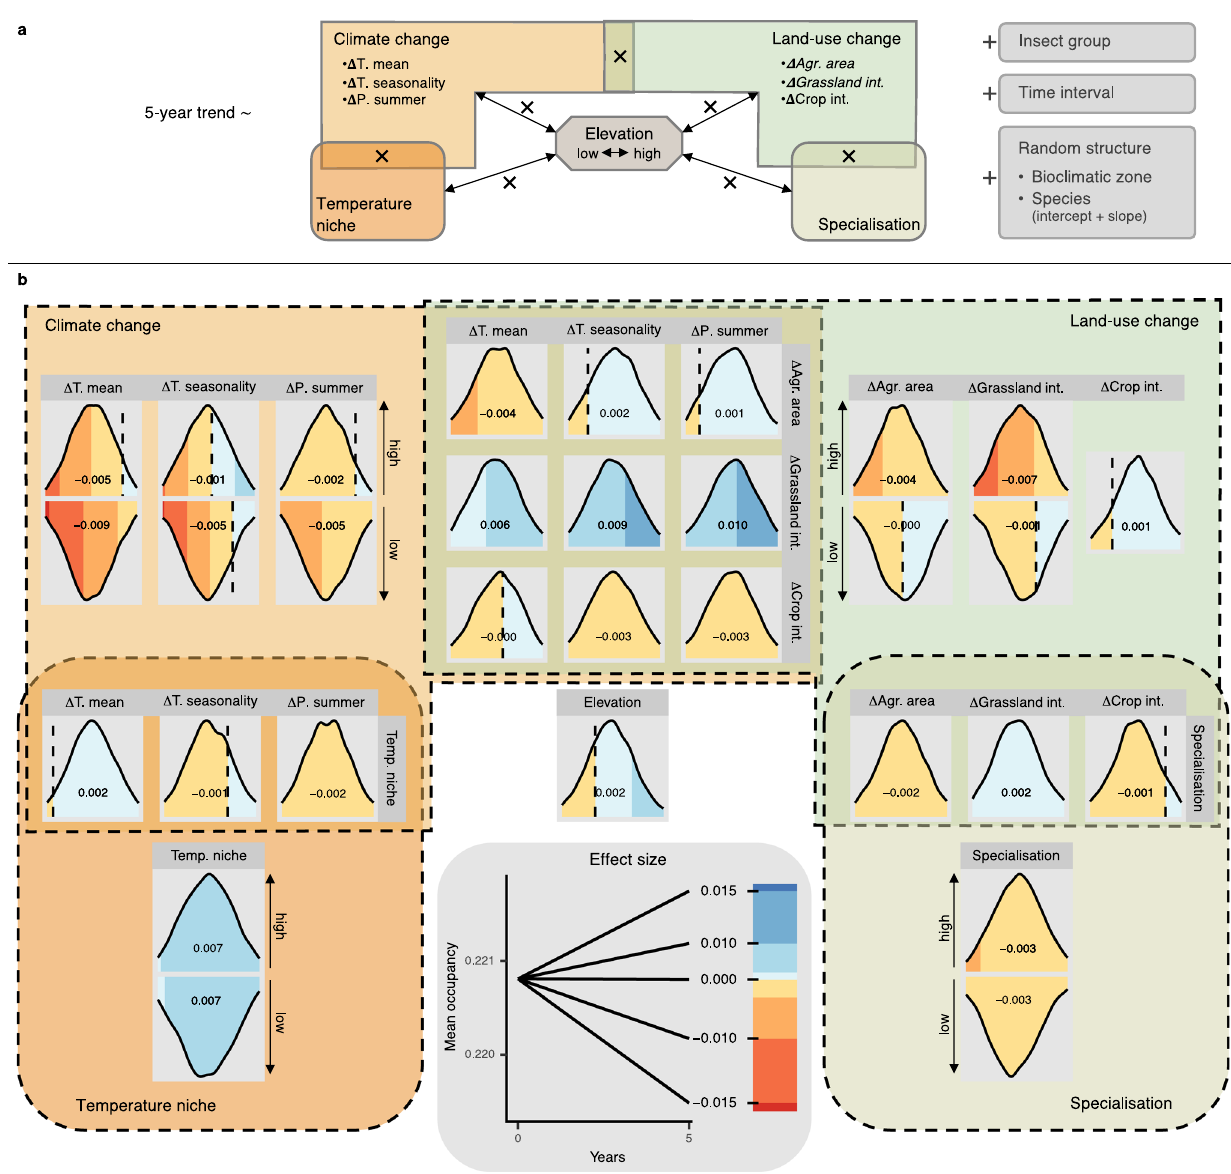
Fig. 3 | Regression model linking climate / land-use changes and species traits to short-term species trends. a Schematic model representation. The response variable was 5-year species trends of regional mean occupancy ( n tot = 20,048). Explanatory variables included changes in climate (annual mean temperature, temperature seasonality, summer precipitation) and land use (total agricultural area,grassland-useintensity,crop-useintensity),twotraitvariables,elevation(low or high) and interactions (indicated with ×) (cf. Fig. 1). In the restricted model version underlying the results presented in panel ( b ), parameter estimates for change in total agricultural area and grassland-use intensity (in italic) were only based on species of agriculturally in fl uenced habitats (183 butter fl y species, 93 grasshopper species; n =13,968). Non-independence within insect groups, time intervals, bioclimatic zones and species was accounted for. b Model results along